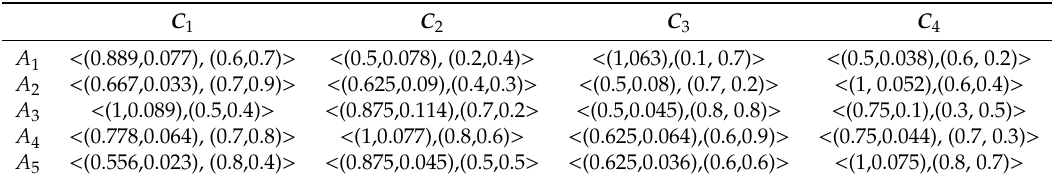
Table 2. Normalized decision